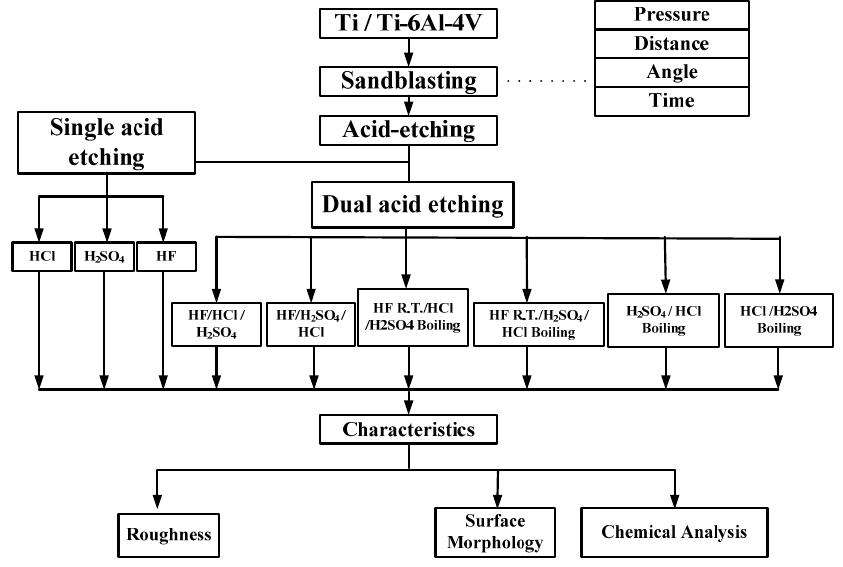
Figure 1. The experimental procedure.